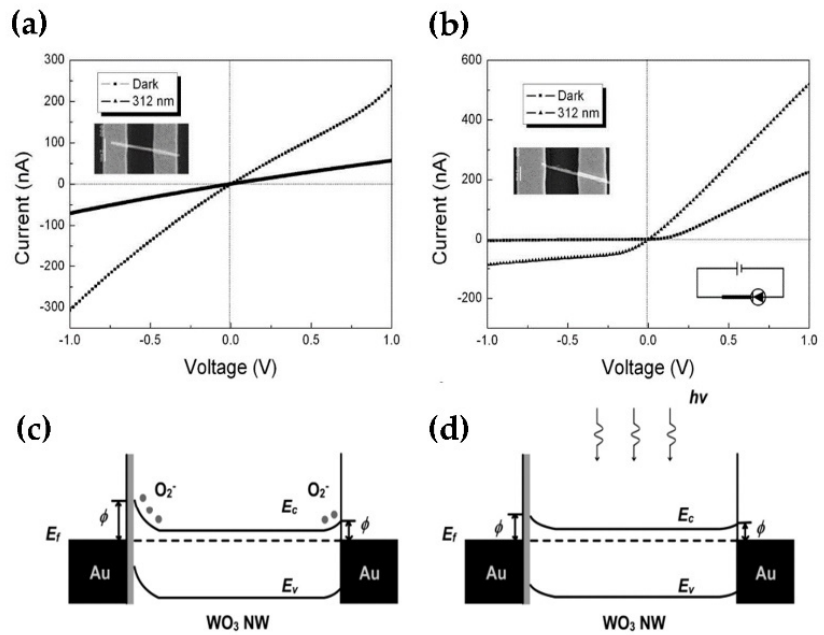
Figure 2. ( a ) A single WO 3 nanodevice symmetrical device both in the dark and under 312 nm UV illumination, and the upper left inset is an SEM image of WO 3 nanowire device. ( b ) I-V characteristics of the nonsymmetrical contact device, upper left inset is an SEM image of WO 3 nanowire device and lower right inset shows the schematic structure of the device. ( c ) Band diagram of the Schottky barrier of the nonsymmetrical device in dark state. ( d ) Under UV illumination, the change of the barrier height. Reproduced or adapted from